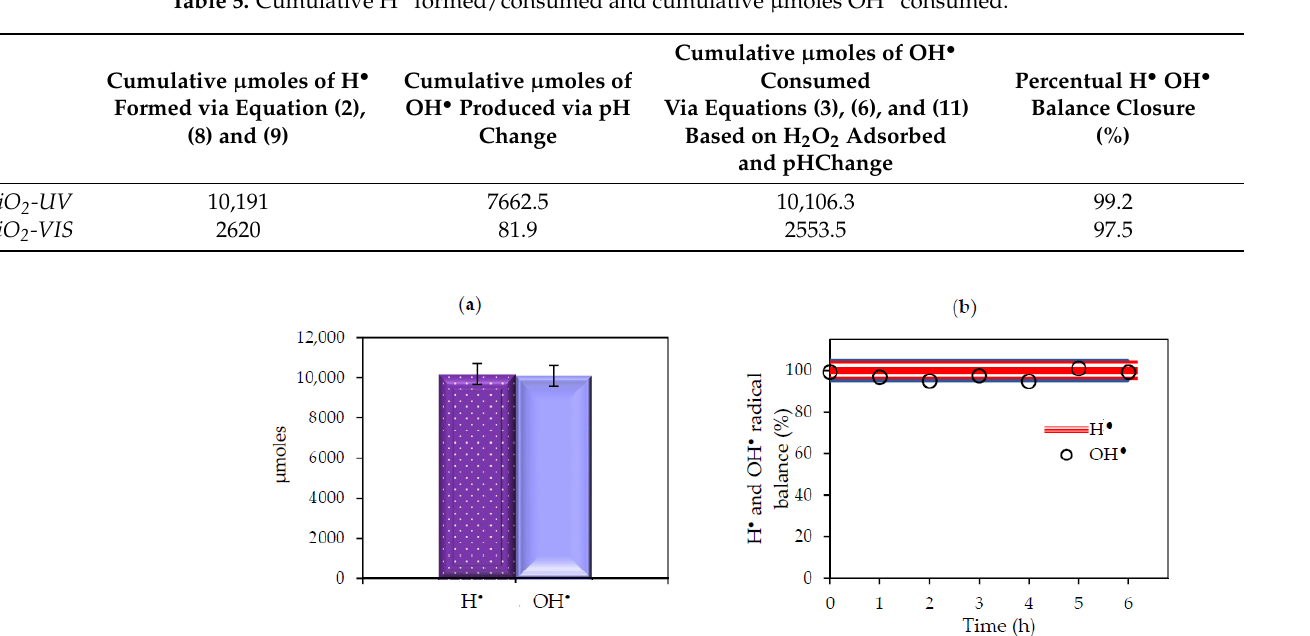
Table 5. Cumulative H • formed/consumed and cumulative µ moles OH • consumed.